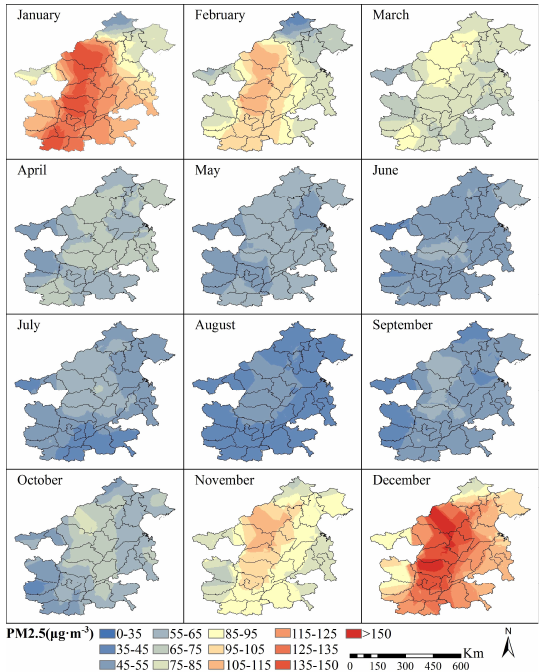
Figure 6. Spatial distribution of monthly PM2.5 concentration in the “2+26” cities 4.2.3 Seasonal Spatial Distribution Characteristics : The spatial variation characteristics of PM2.5 seasonal concentration was described from figure 7.